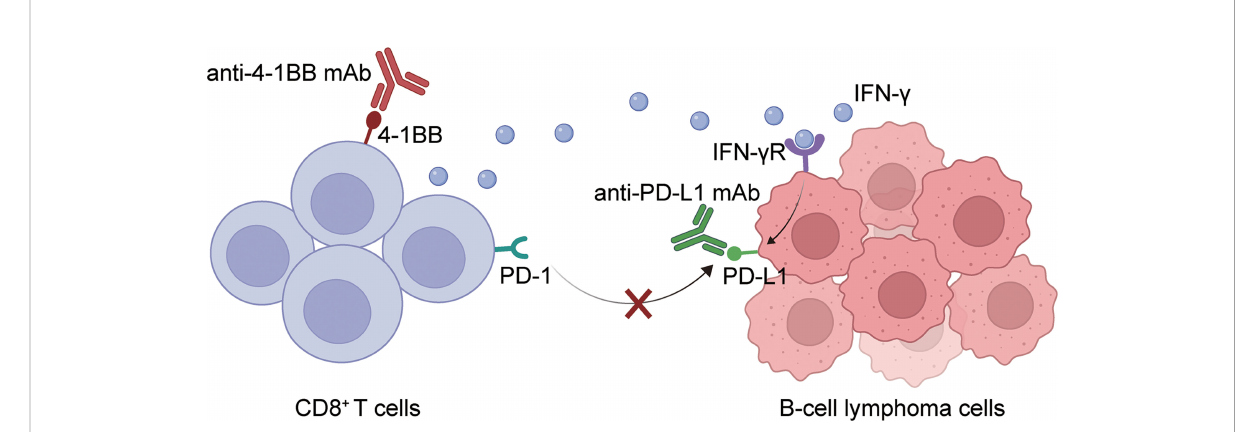
FIGURE 6 A graphical description of how PD-L1 blockade and 4-1BB agonism elicited enhanced antitumor effect in BCL. The combination of 4-1BB agonist and anti-PD-L1 antibody can activate T cell function and increase the expression of cytokines such as IFN- g . On the other hand, it can release the inhibition of T cells by tumor cells by blocking the PD-1-PD-L1 signaling axis. Thus, eliciting a more signi fi cant anti-tumor